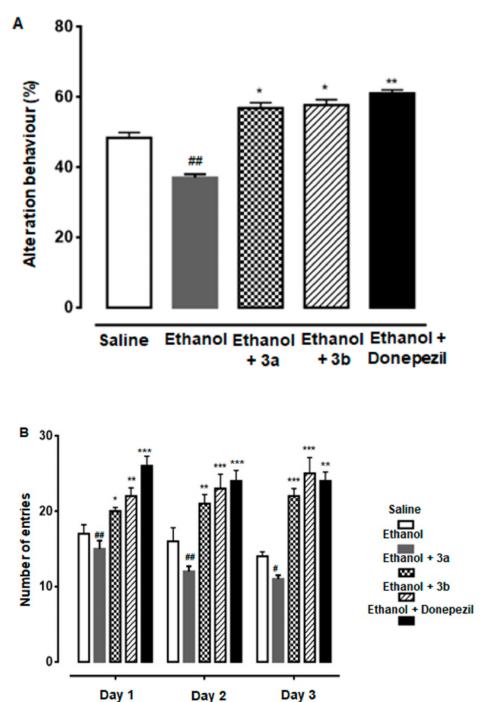
Figure 3. ( A ) Spontaneous alteration behavior % of the rats during the Y-maze test. Mean ± SEM for the rats ( n = 6 / group). ## shows significantly di ff erent from the control; *, ** shows significantly di ff erent from the ethanol-treated group. Significance: p < 0.05. ( B ) Average escape latency time for experimental rats to reach the hidden platform from one to three days. Mean ± SEM for the rats ( n = 6 / group). #, ## shows significantly di ff erent from the control; *, **, *** shows significantly di ff erent from the ethanol-treated group. Significance: p <